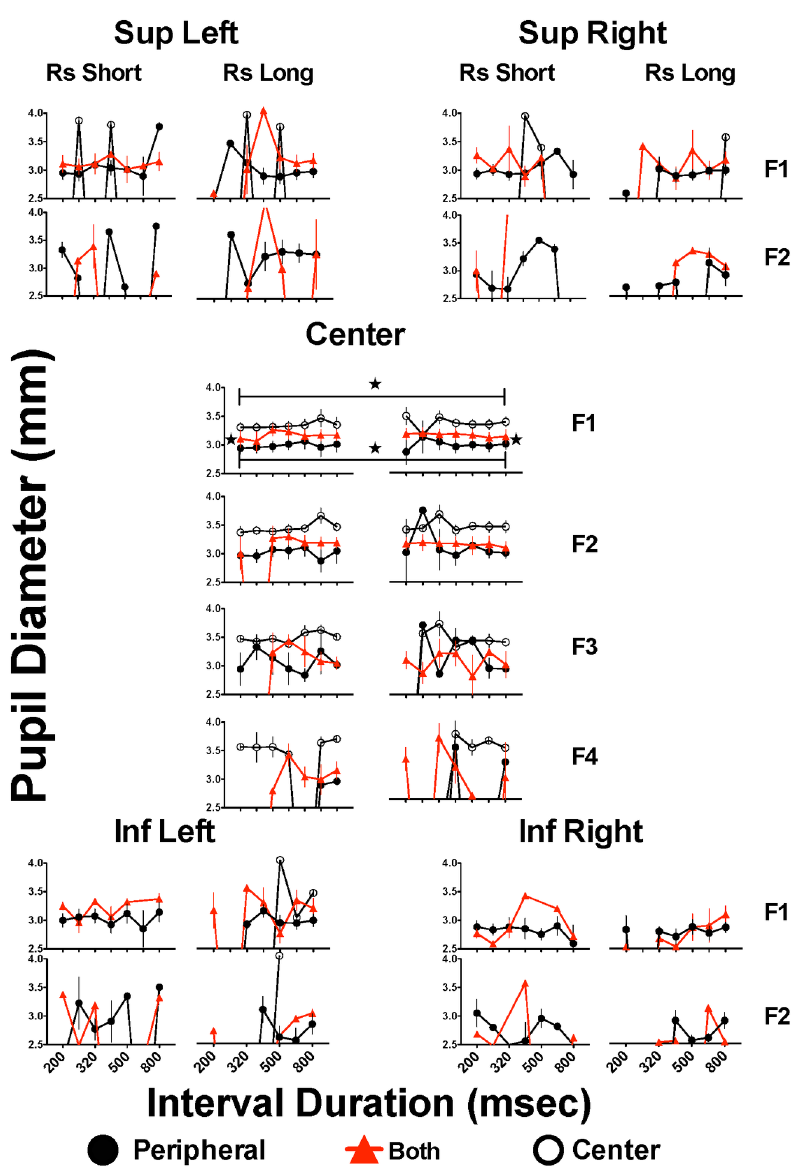
Fig 4. Mean pupil diameter in successive fixations on each Area of Interest during generalization trials. Mean pupil diameter in each successive fixation to each Area of Interest (AoI) where stimulus could appear: fixation 1 (F1) to fixation 4 (F4) for Centre AoI but only F1 and F2 for remaining AoIs. For each fixation to each AoI, left panels present the performance on trials where subjects categorized intervals as “ short ” and right panels correspond to categorizations as “ long ” ; only intervals close to or at the extreme durations present mean of 15 subjects since some subjects never emitted erroneous categorizations. Stars and horizontal bars indicate significant differences between denoted groups after two-way ANOVA followed by Bonferroni´s test (p < 0.05) (see text); only data from anchor intervals with N = 15 were included in statistical